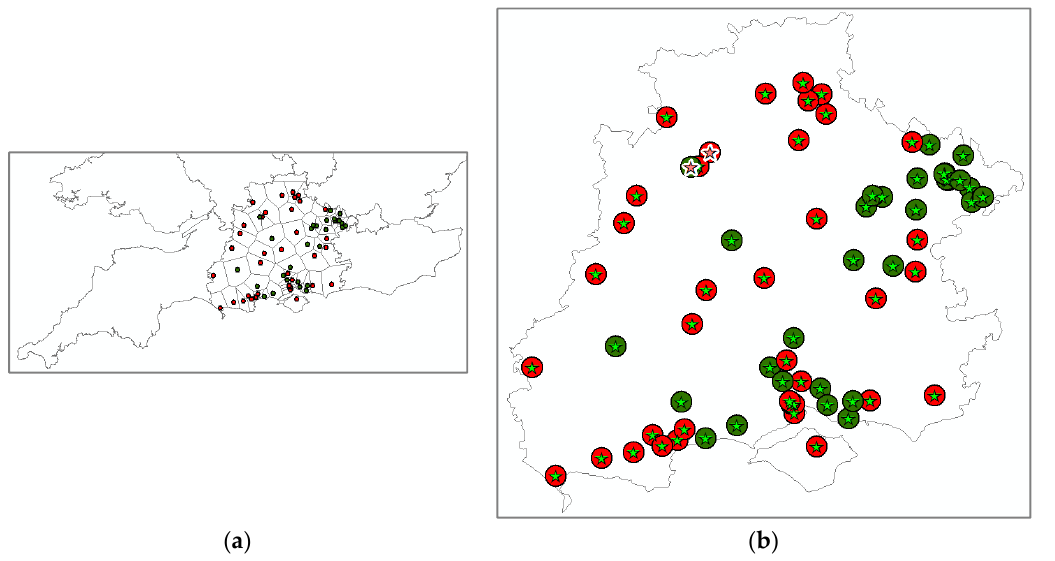
Figure 9. Calculated overloads compared to DNO company constraints on BSP in Southern DNO. ( a ) Total capacity of solar farms per BSP Thiessen polygon; ( b ) overloads and constraints on BSPs.